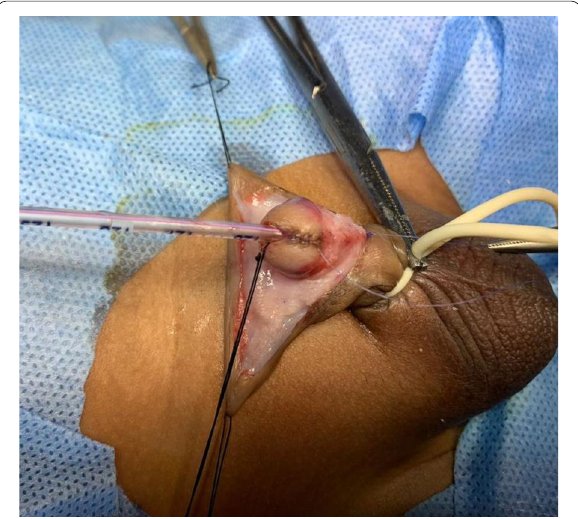
Fig. 5 Glanuloplasty is done in two layers. The suturing of the Buck’s Fascia continues into the inner raw surface of glans which is then brought outside and glans closed externally in a continuous manner. The suture is tied at coronary skin collar